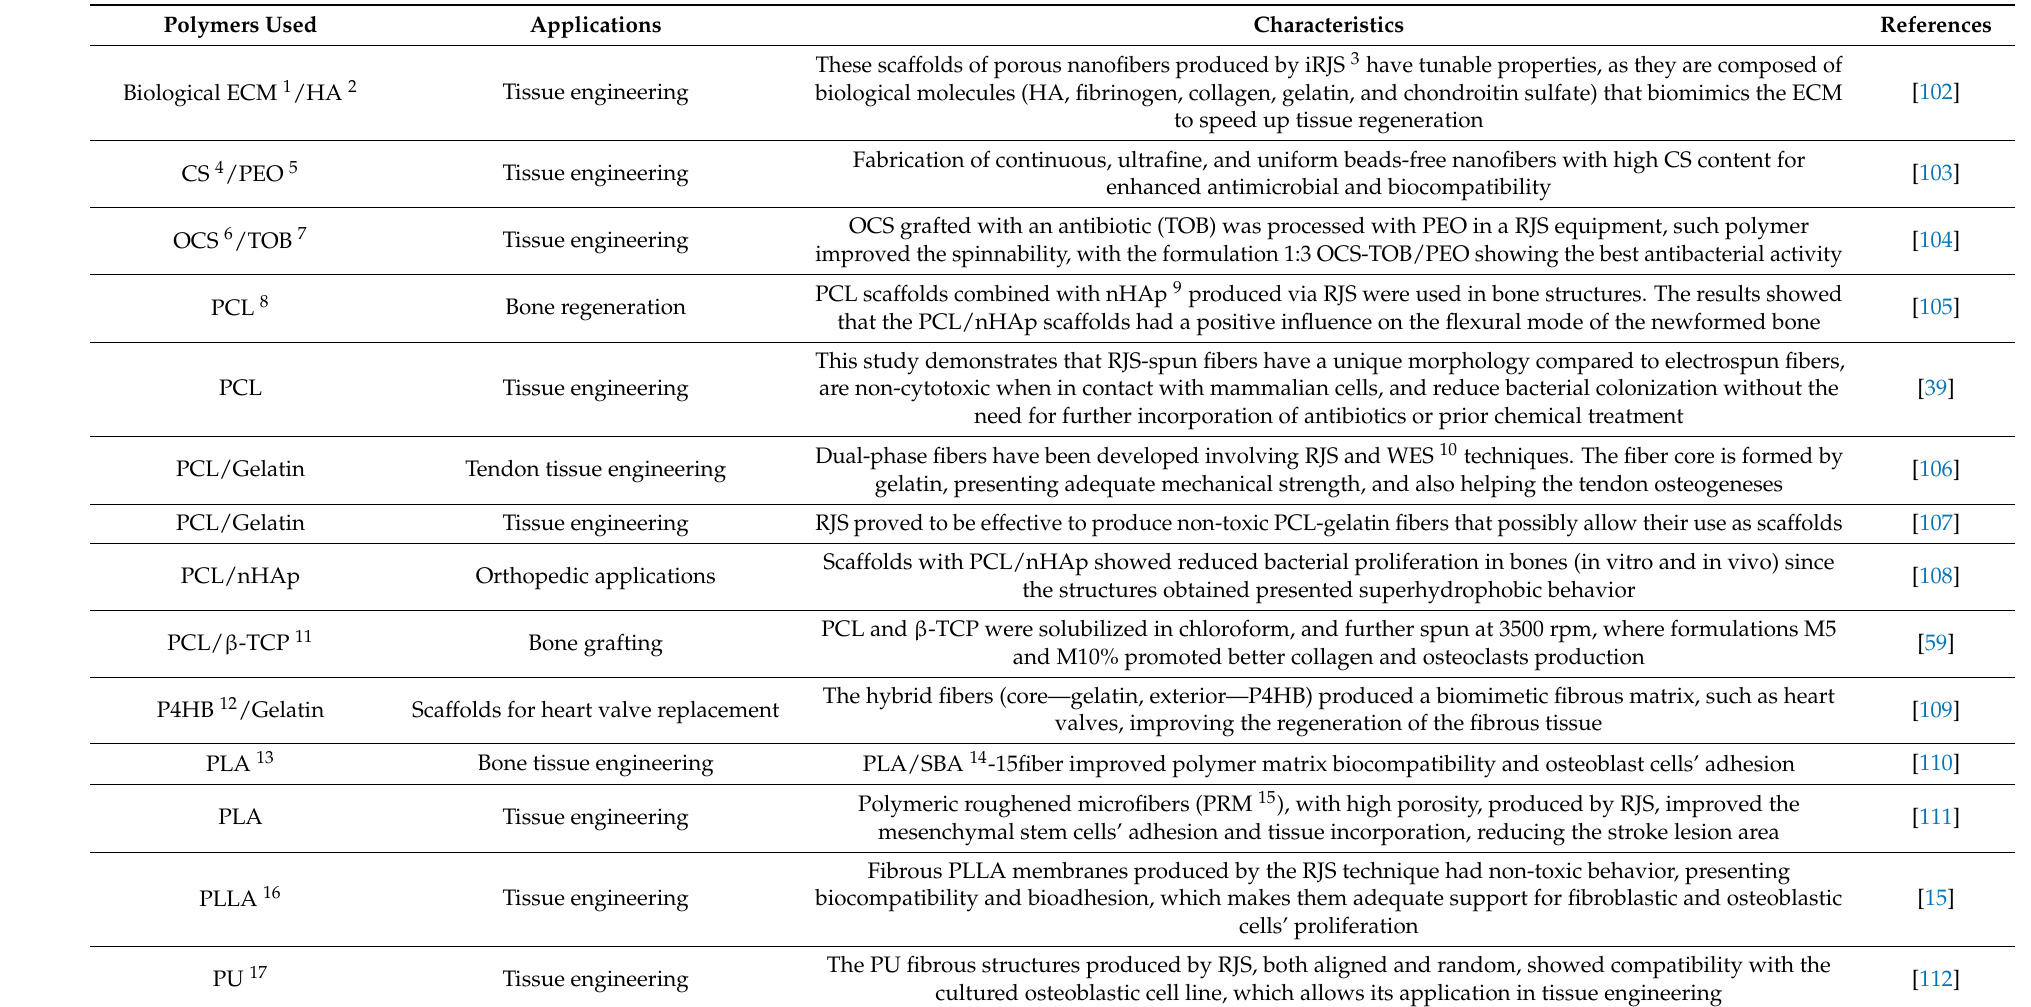
Table 3. Recent developments in polymeric nanofibers produced by RJS in the biomedical